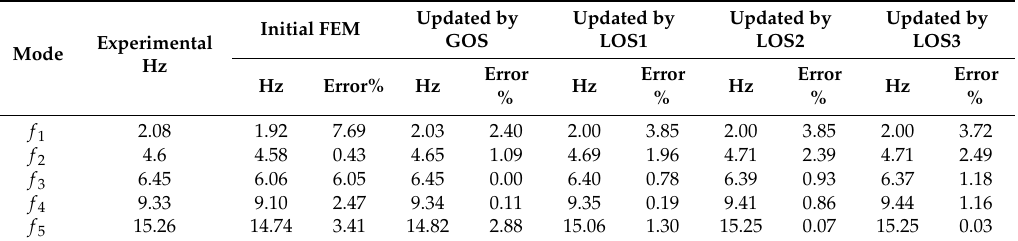
Table 12. The error between theoretical frequencies and measured values corresponding to each group of solutions.